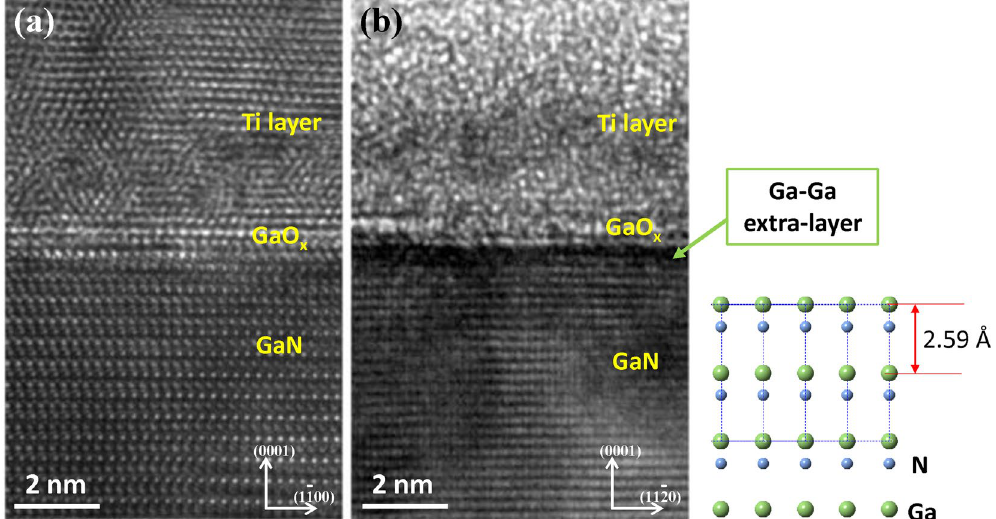
Figure 3. The HRTEM observation of Ti-GaN interface, before ( a ) and after ( b ) Ar + ion sputter on sample N2. Inset: GaN (0001) ball